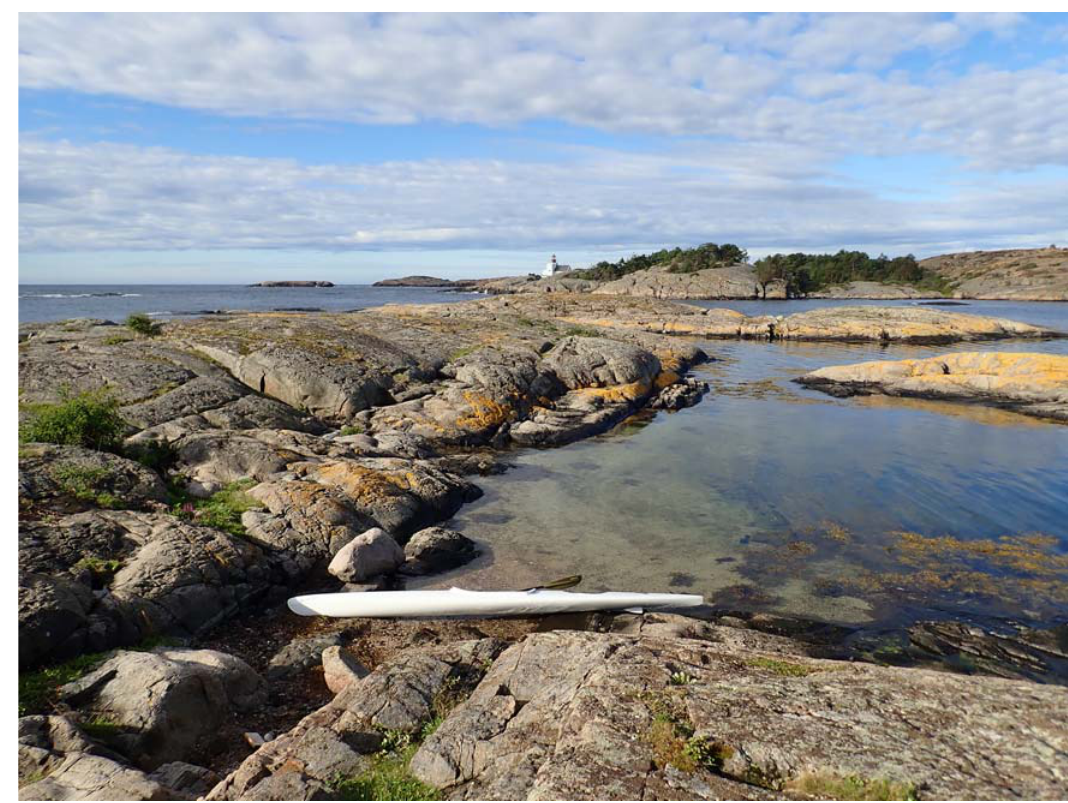
Figure 2: In the MM as today, the Norwegian archipelago with islets and skerries surrounded by the open sea, as well as larger islands with sheltered bays, surrounded by shallow waters. Photo: Tom